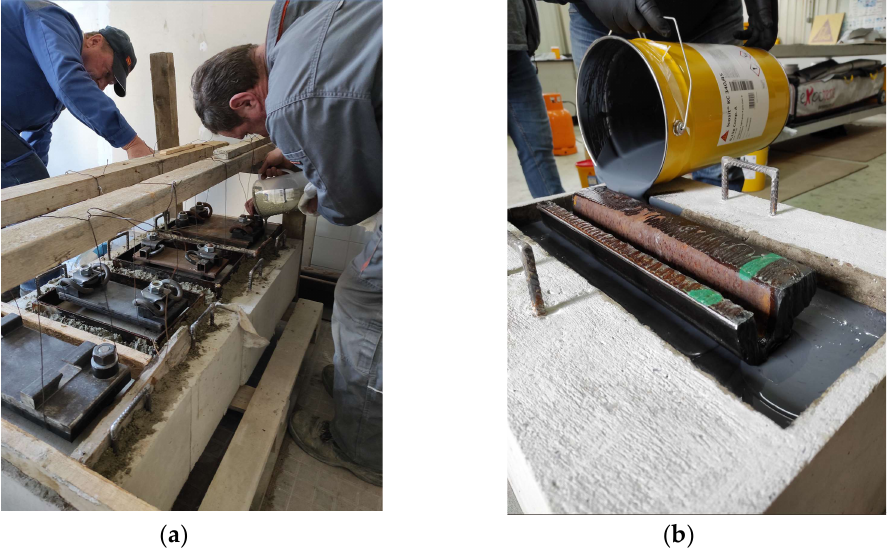
Figure 9. Sample preparation for the laboratory measurement: ( a ) discretely fastened rail and ( b ) embedded rail.